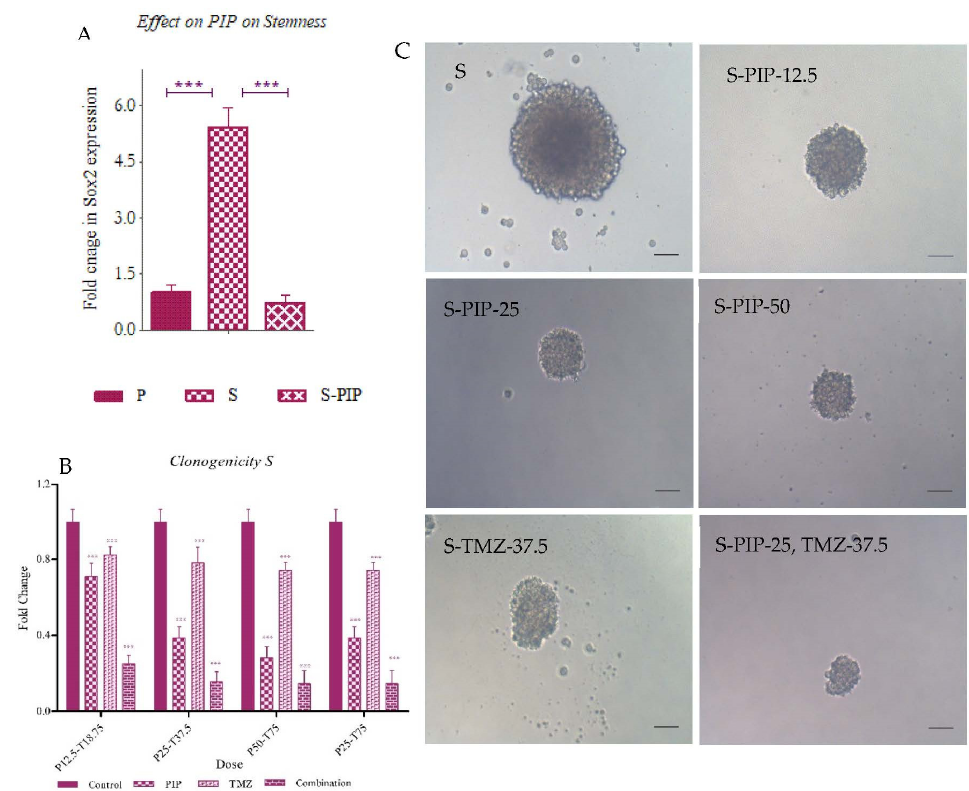
Figure 13. Effect of survivin inhibition on stemness. ( A ) The expression of stemness marker Sox2 in PIP treated cells using RT ‐ PCR ( B ) Clonogenic potential in the isolated GSCs with single drug and combination treatments. ( C ) Representative images of colony formation in the S pool with and without treatment. The graphical data are presented as mean ± SD and the statistical analysis was performed using one ‐ way ANOVA (***: p ‐ value < 0.001). The scale bar indicates 20 μ m.